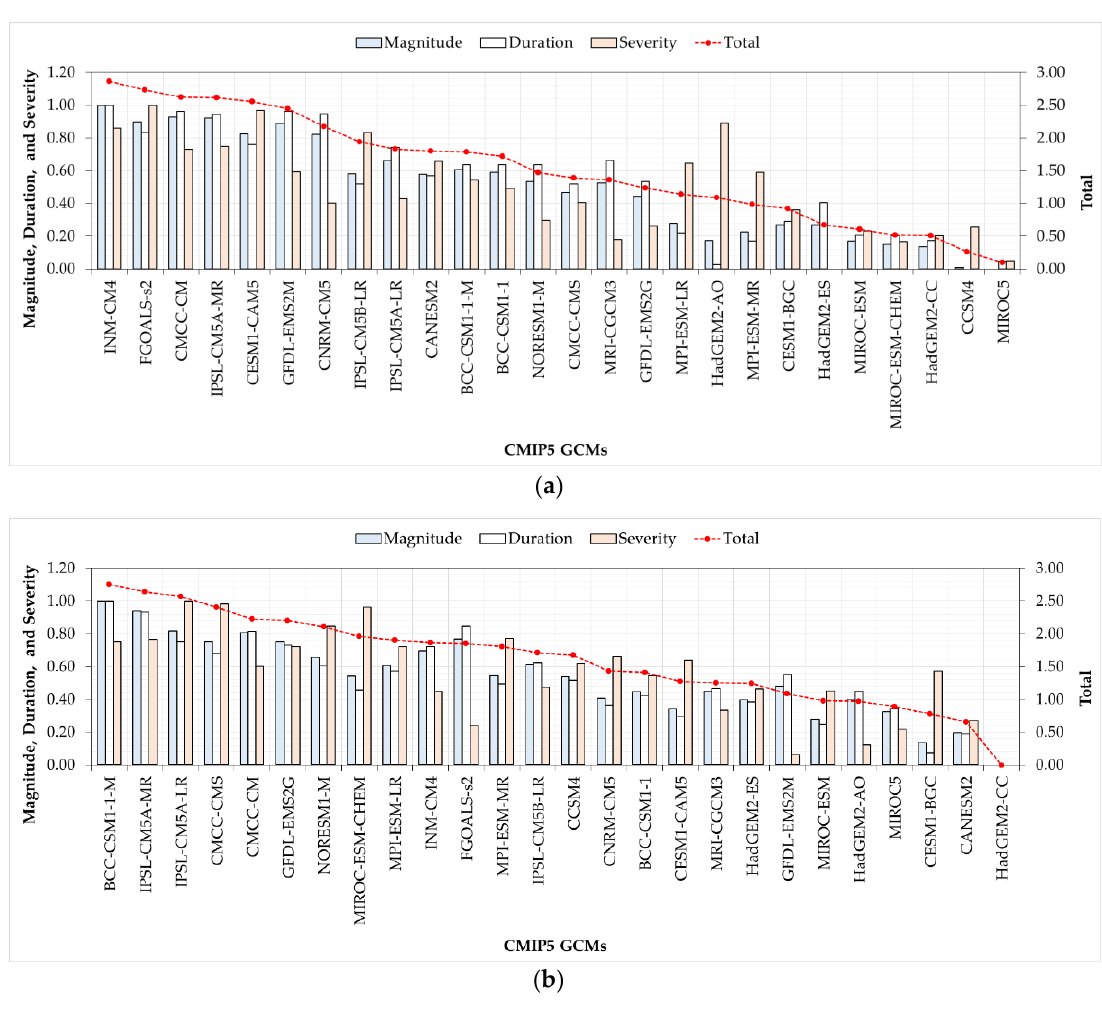
Figure 5. The dryness ranking of Representative Concentration Pathway (RCP) 4.5 ( a ) and 8.5 ( b ) scenarios for the 26 CMIP5 GCMs (Total = Magnitude + Duration + Severity).